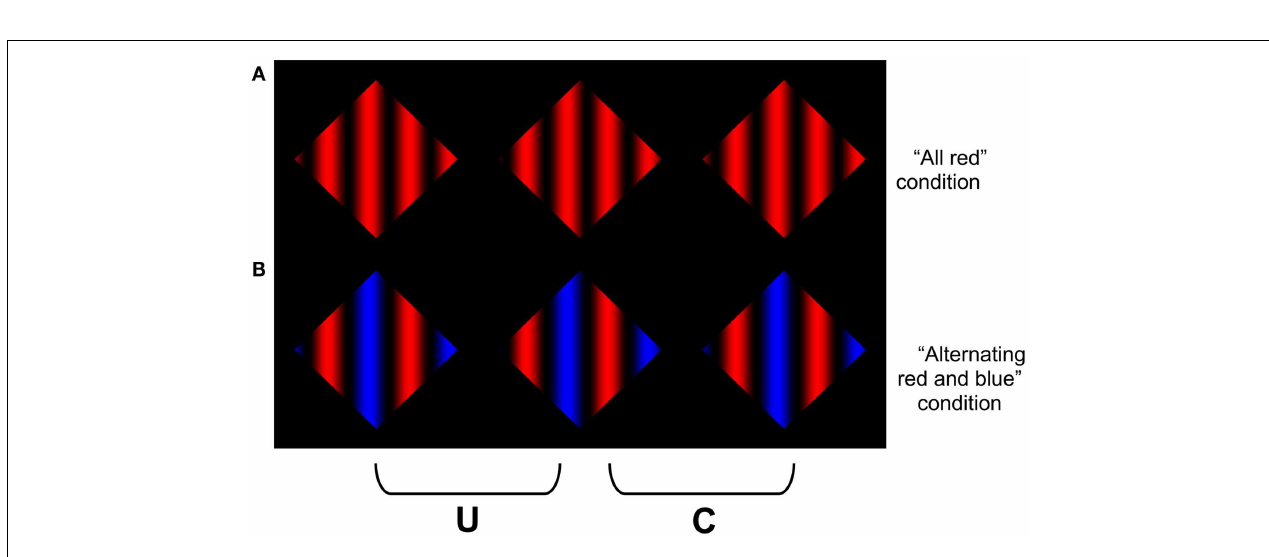
percept of an amodally completed surface in (B) .To avoid the modal completion of the dark “components” of the grating across the surround, the reader is advised to occlude the other images in the figure when viewing each row of the